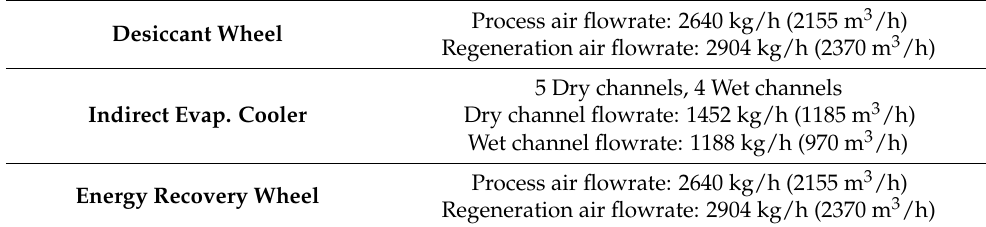
Table 1. Parameters settings for the system components.